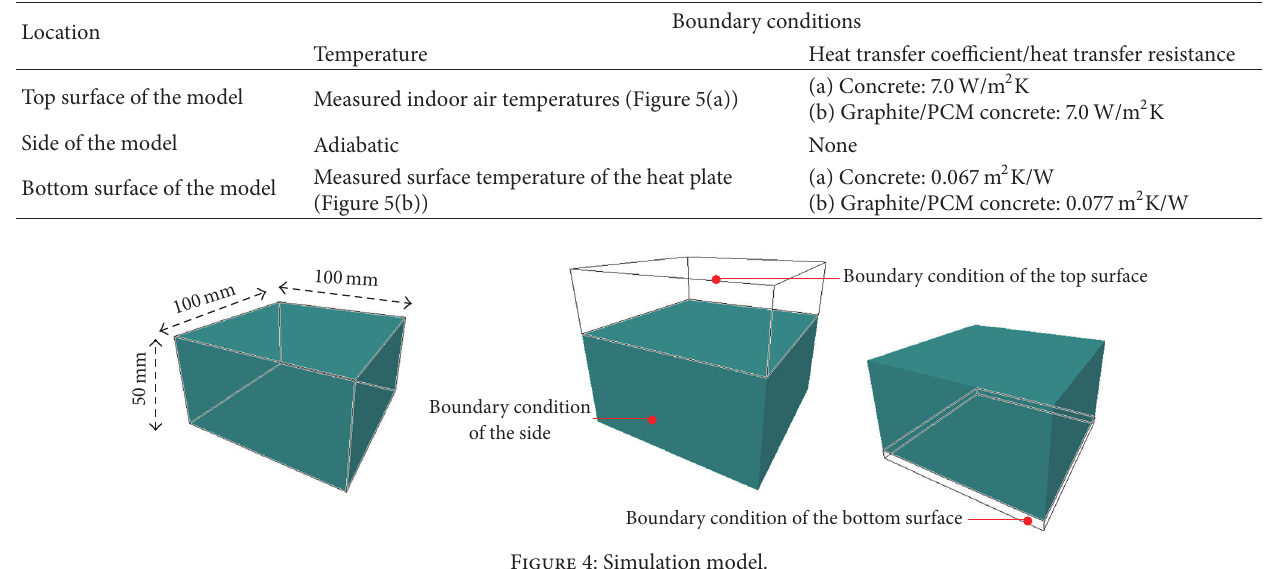
Figure 4: Simulation model.